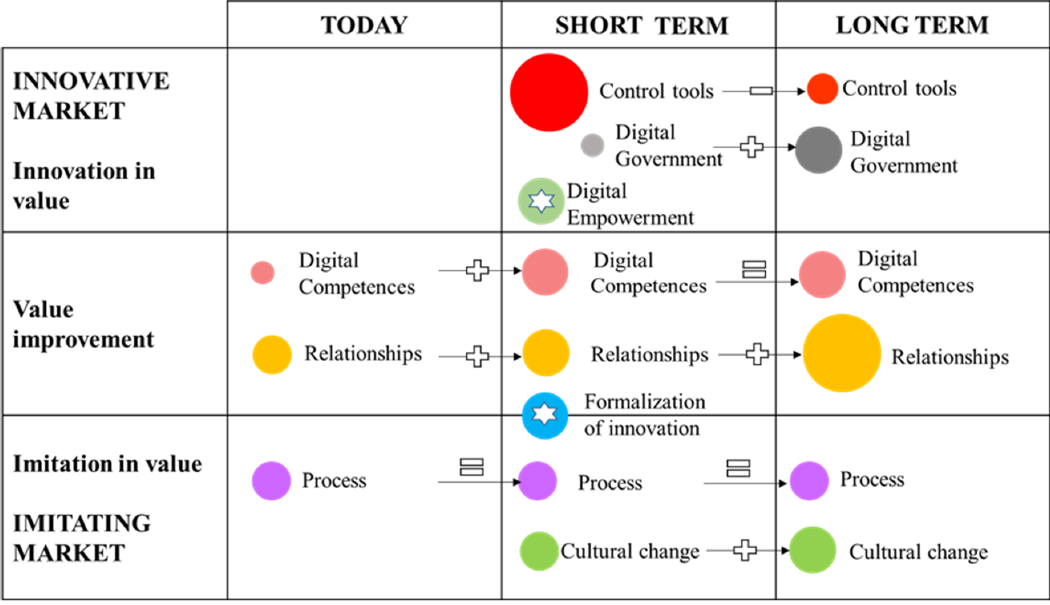
Figure 4. Port groups by degree of scanning.